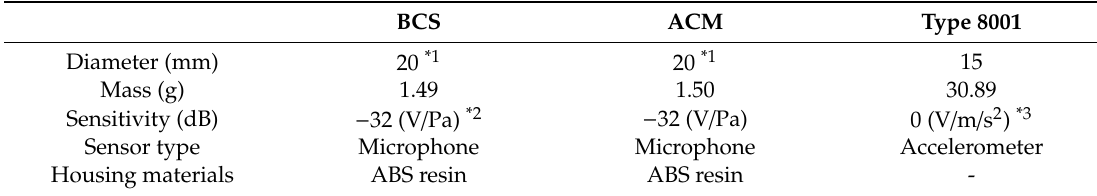
Figure 2. Photographs and structures of the sensors. Table 1. Specifications of the sensors.